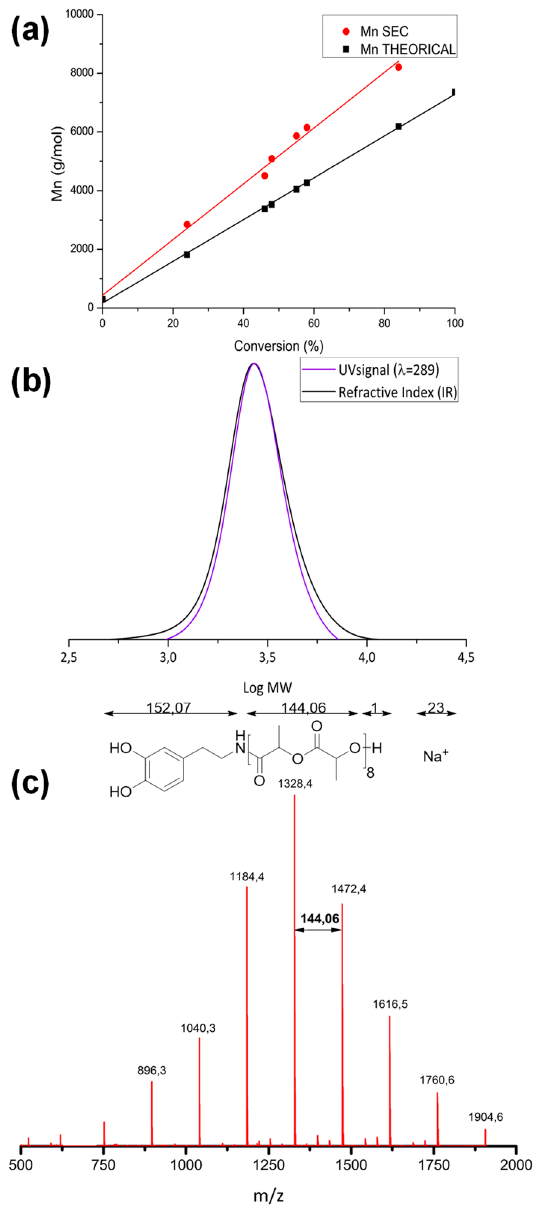
Figure 2. ( a ) Molecular weight vs. conversion graph of PLLA using dopamine as initiator, [( a ) entry 7]; ( b ) SEC trace with UV (289 nm wavelength) and refractive-index signals for semitelechelic catechol PLLA; ( c ) MALDI-TOF spectra for semitelechelic catechol-PLLA. [( b , c ) Entry